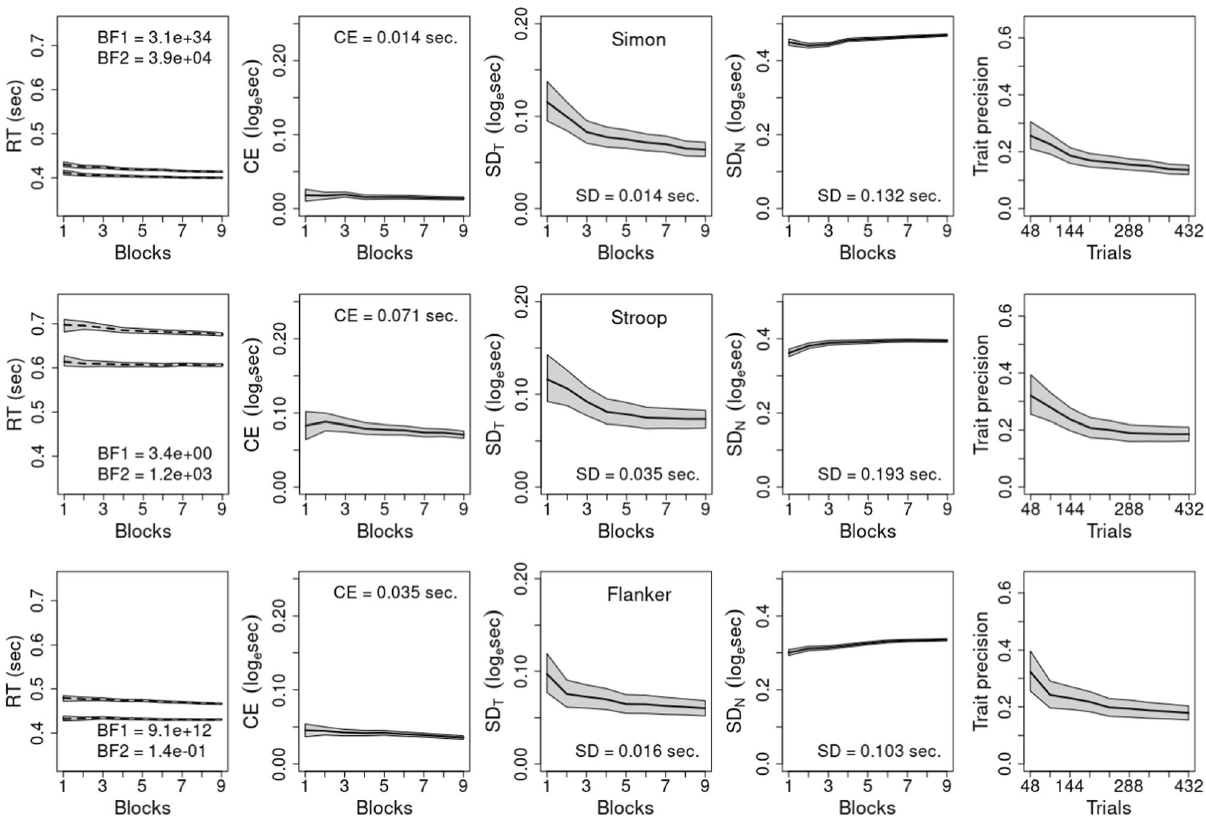
Fig. 4 |ResultsforHedgeet al.data. Amodelassuming additivepractice(blocks) andcon fl ict fi xedeffects,andrandomsubjectinterceptsandcon fl ictslopes.Blocks refer to cumulative sets of 48 trials and each row represents one task. In the fi rst column,dashedlinesshowmeanresponsetime(RT)forcongruent(lowerline)and incongruenttrialscalculateddirectlyfromdataandBayesFactors(BF)comparethe assumed model in the numerator to models with (1) no practice effect and (2) a